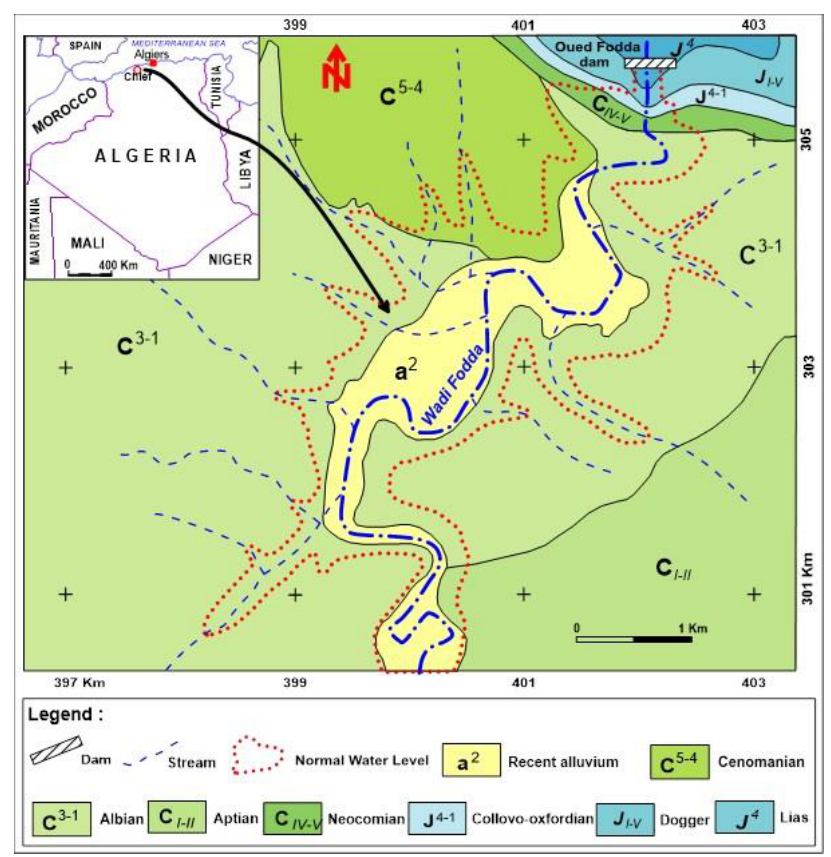
Fig. 1. Geological map of study area (Extract from the geological map of Ech-Chlef 1/200000, modified by the